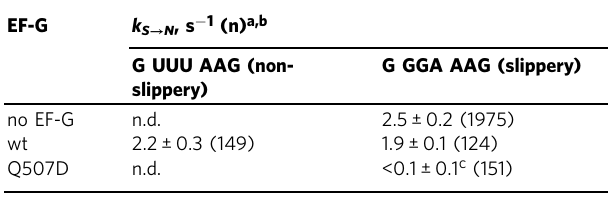
Table 3 Kinetics of SSU head